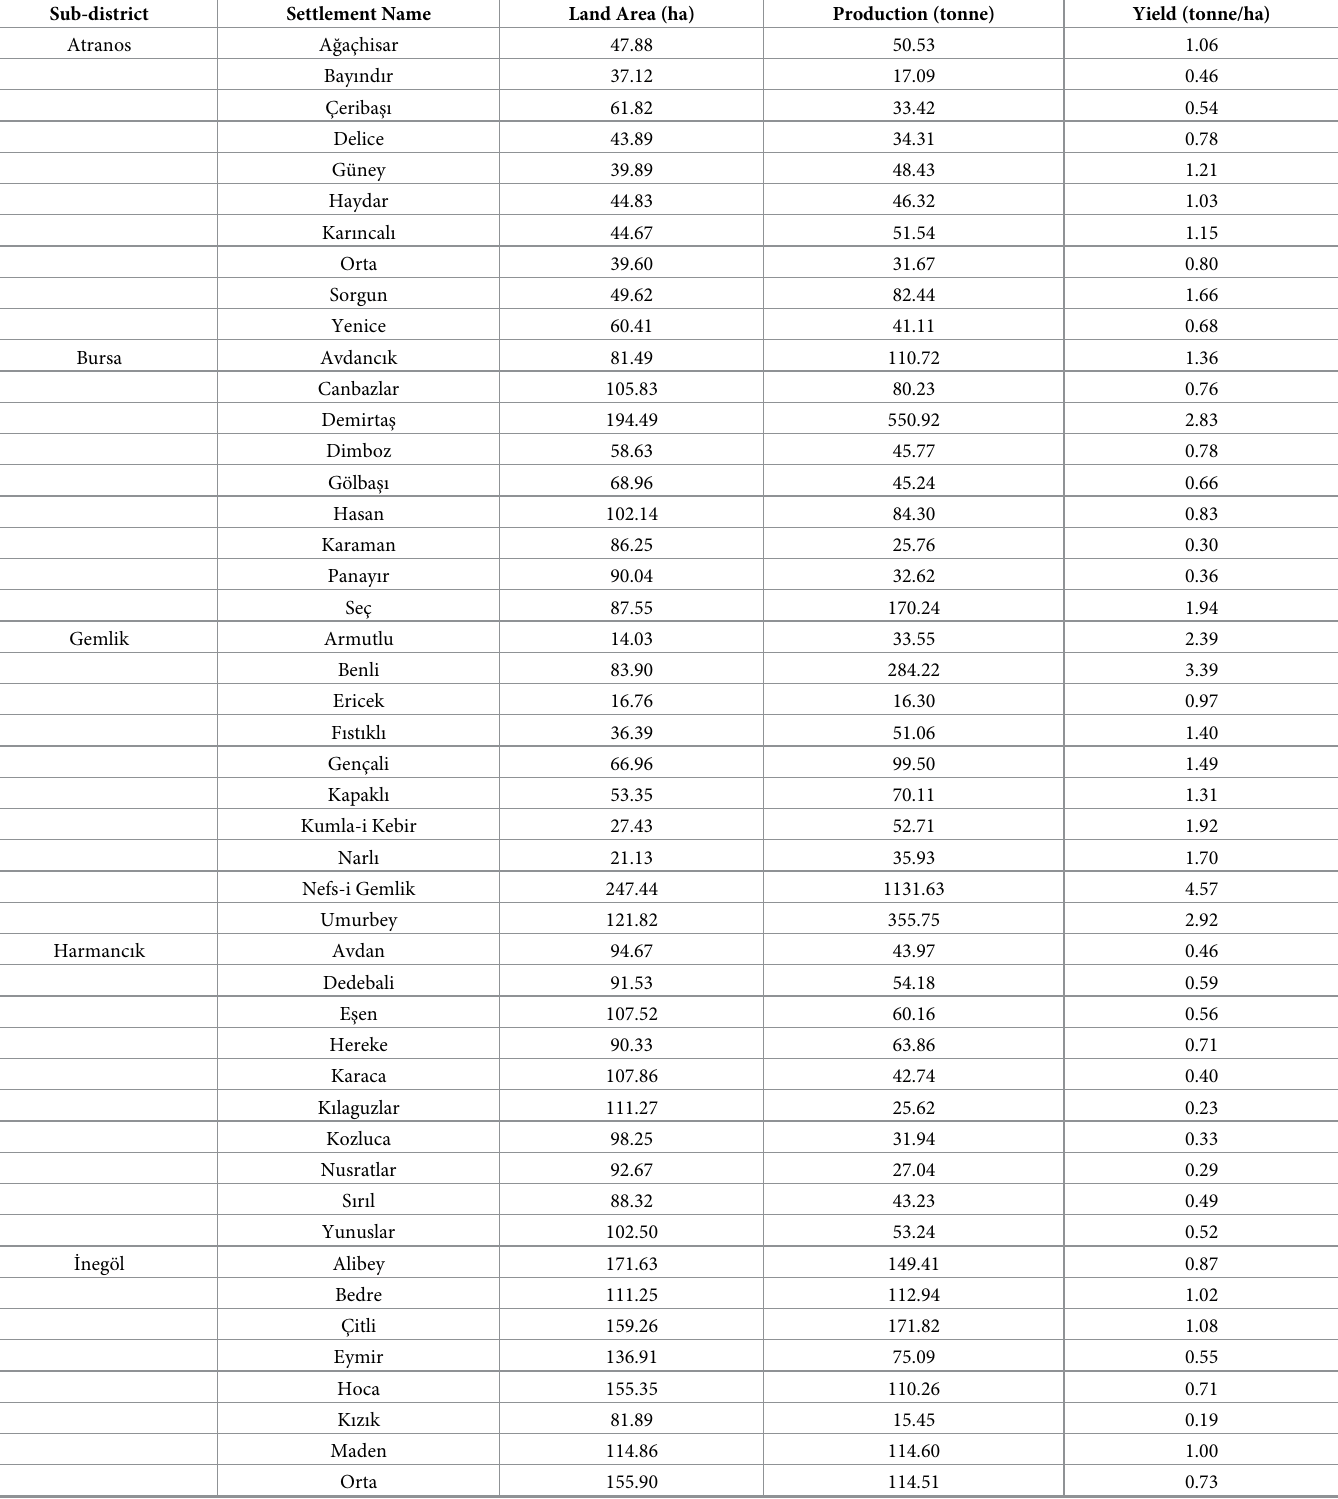
Table 9. Details of estimates of agricultural land area, production and yield in selected settlements of Bursa Region.